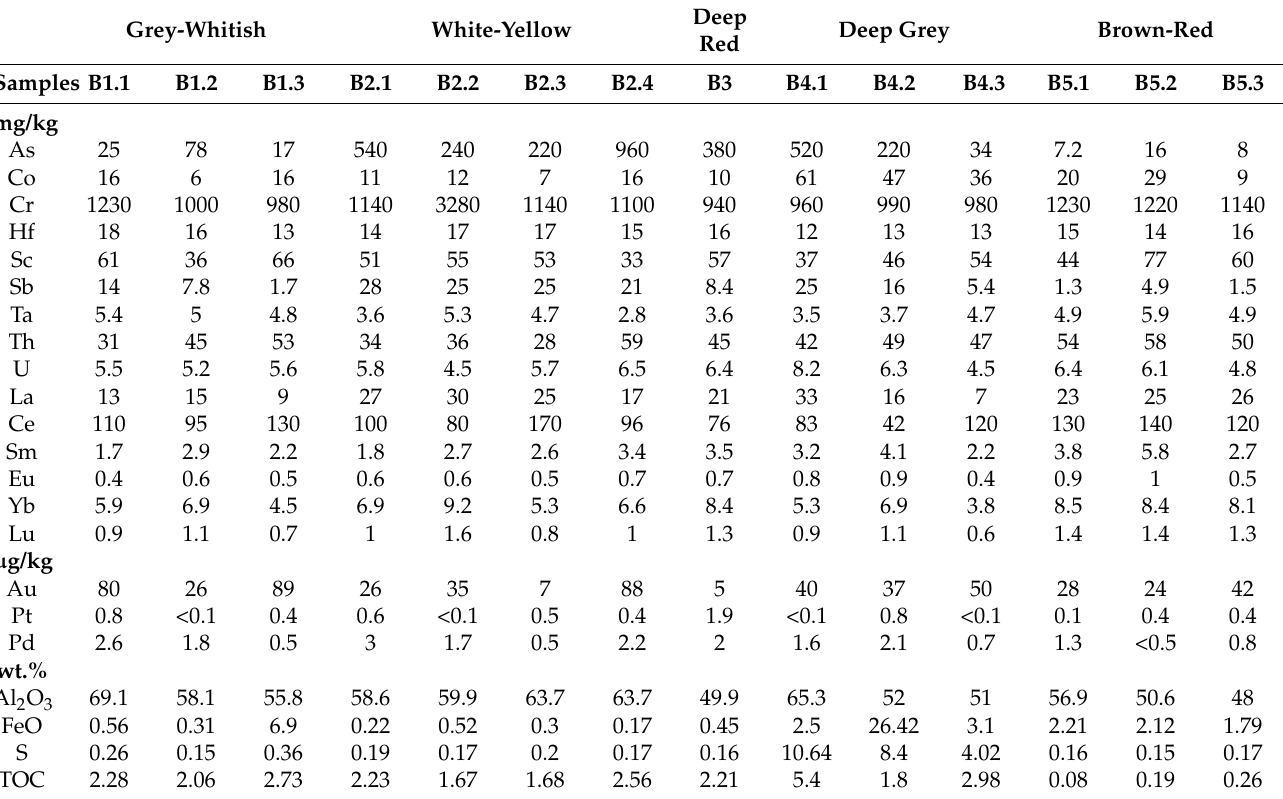
Figure 1. Stratigraphic column of the Parnassos-Ghiona bauxite deposits, showing the bauxite formations in relation to the age on the associated limestones ( a ) and the brief sequence of the studied bauxite types, along a profile from B3 formation, although there is commonly coexistence on yellow, grey, and deep red bauxite, in a varying proportion ( b ). Table 1. Major and trace element content in bauxite from the Parnassos-Ghiona deposit, along a profile underlying a fault (Figure